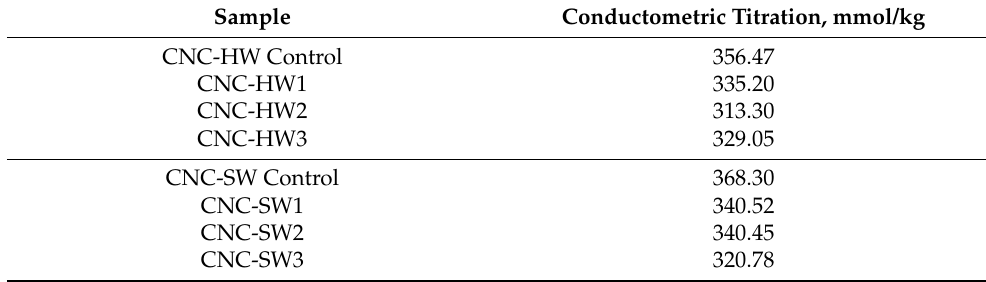
Table 6. Total sulfur and sulfate half-ester contents on different CNC